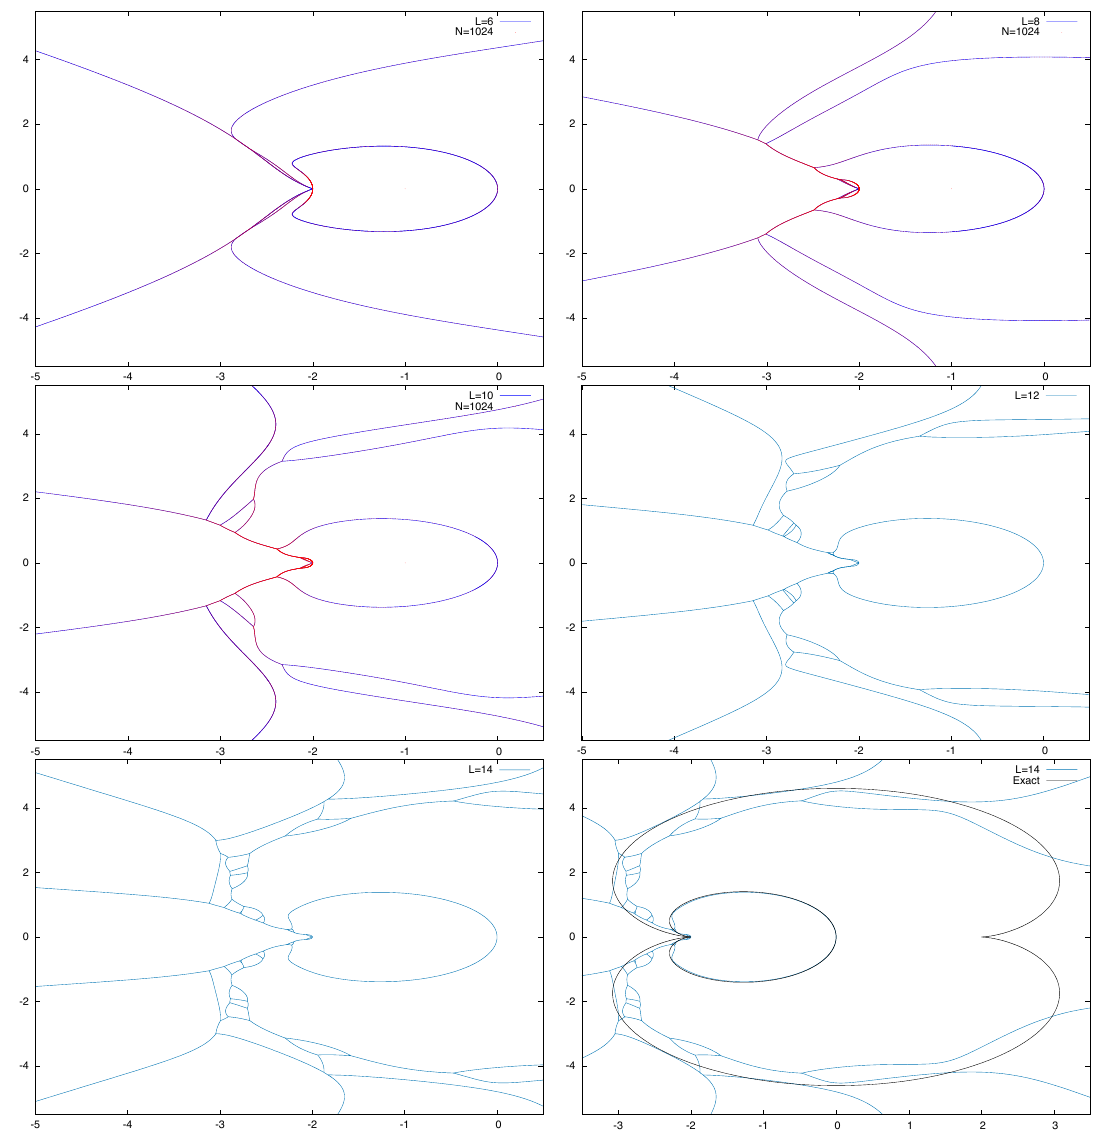
Figure 3 . Condensation curves in the complex m -plane for partition-function zeros of the loop model on L × N tori, in the limit N → ∞ . The panels show, in reading direction, the cases L = 6 , 8 , 10 , 12 , 14 . The first three panels also superpose the partition-function zeros for a finite system with N = 1024 (in red color). The last panel compares the L = 14 curves with an exact prediction for the thermodynamic limit ( L → ∞